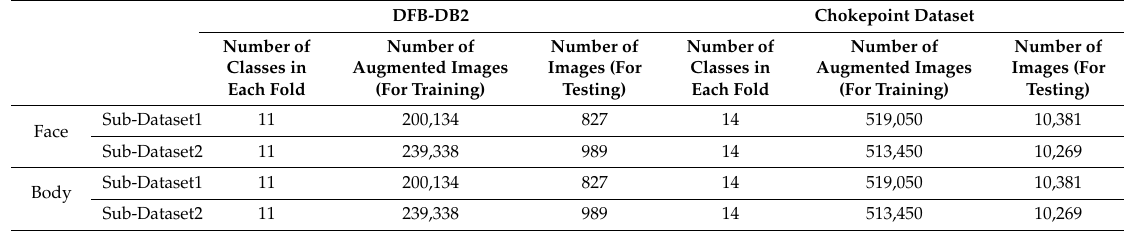
Table 4. Total images of DFB-DB2 and ChokePoint